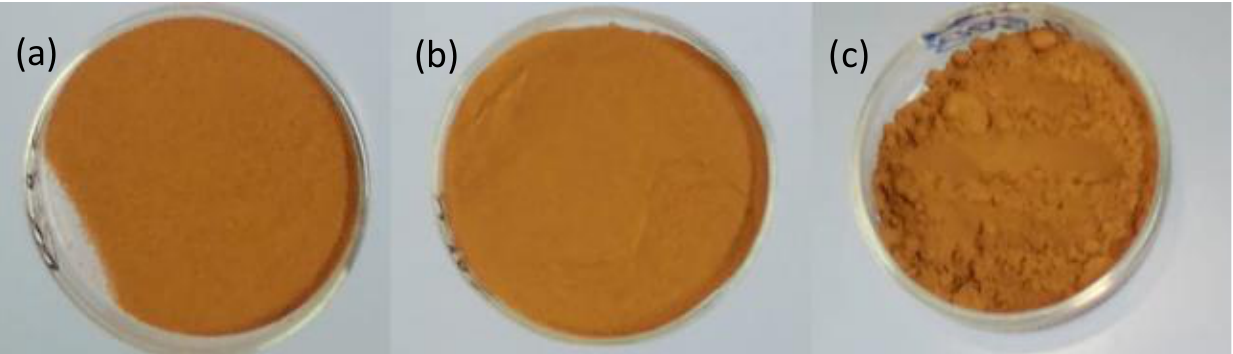
Figure 10. The different stages of almond bark powder preparation. Figure 2. The different stages of almond bark powder preparation. Figure 2. The different stages of almond bark powder preparation.